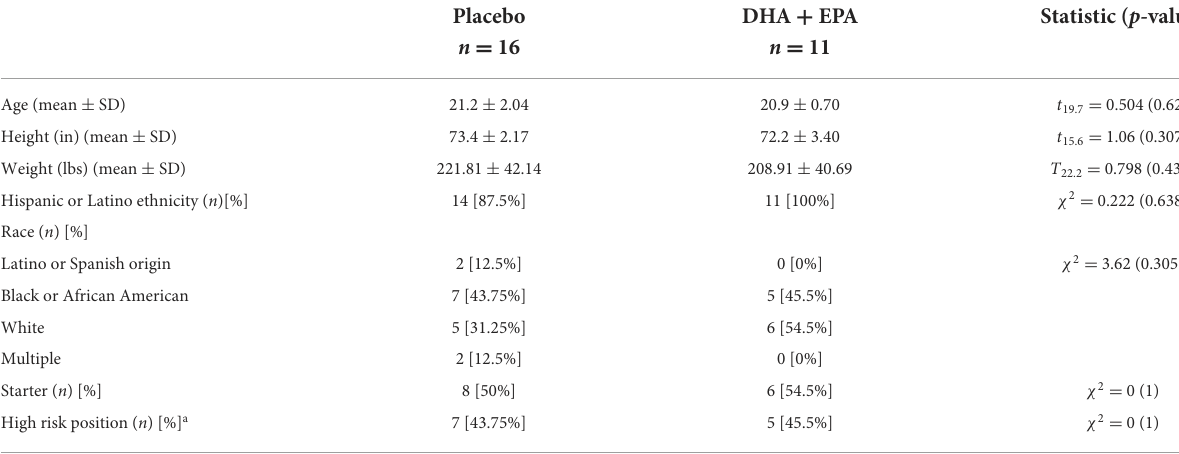
TABLE 1 Demographic characteristics of participants completing the trial and all imaging.